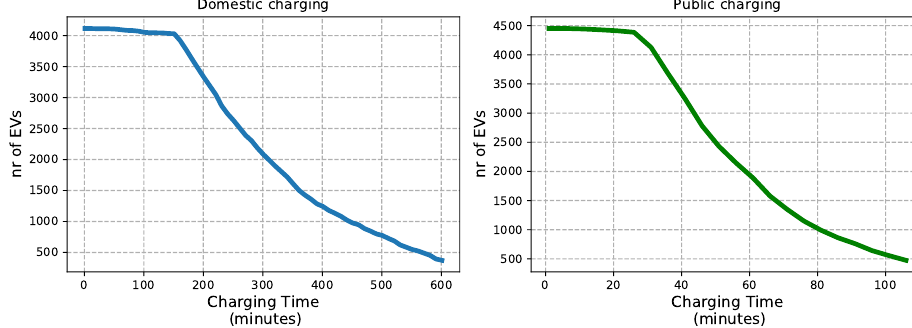
Figure 12. Duration curves of charging time for domestic and public charging in Scenario 2c.